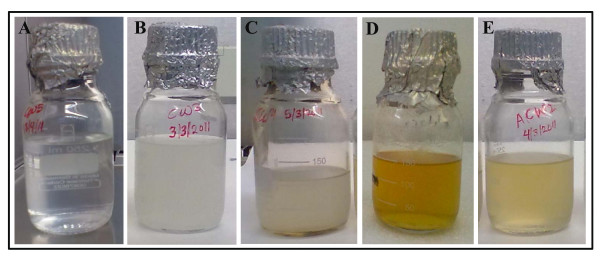
Pictures of coconut water before and after sterilisation and storage at 4°C. (A). Fresh coconut water after extraction. (B). Fresh coconut water after two weeks of storage at 4°C. (C). Irradiated coconut water after four weeks of storage at 4°C (no significant difference to the observation before and after two weeks of storage). (D). Autoclaved mixture of coconut water before storage. (E). Autoclaved coconut water after two weeks of storage. For B, C and E, the increase in turbidity/cloudiness of the water masked the intensity of the yellow colour; however, it was observable after centrifugation.